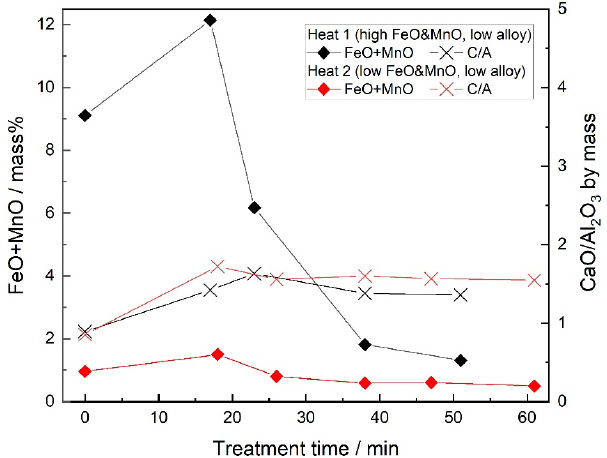
Figure 10. CaO/Al 2 O 3 ratio and FeO and MnO contents of theslag used for heat 1 and heat 2. The same comparison was made for heat 3 and heat 4, as shown in Figure 11. Like heat 2, the FeO and MnO contents for heat 3 and heat 4 were low and decreased a little with time. Compared to heat 1 and heat 2, the stable C/A ratio for heat 3 and 4 was higher, which was about 2. A. Harada et al. reported that the formation of the MgO–Al 2 O 3 spinel inclusion was little affected by the C/A ratio when the CaO/SiO 2 (C/S) ratio of the slag was high [23]. In this study, the C/S ratio was always higher than five, and all slags were saturated with CaO. Therefore, the difference in the C/A ratio was neither the reason for the formation of the MgO–Al 2 O 3 spinel nor the CaO–Al 2 O 3 inclusion.